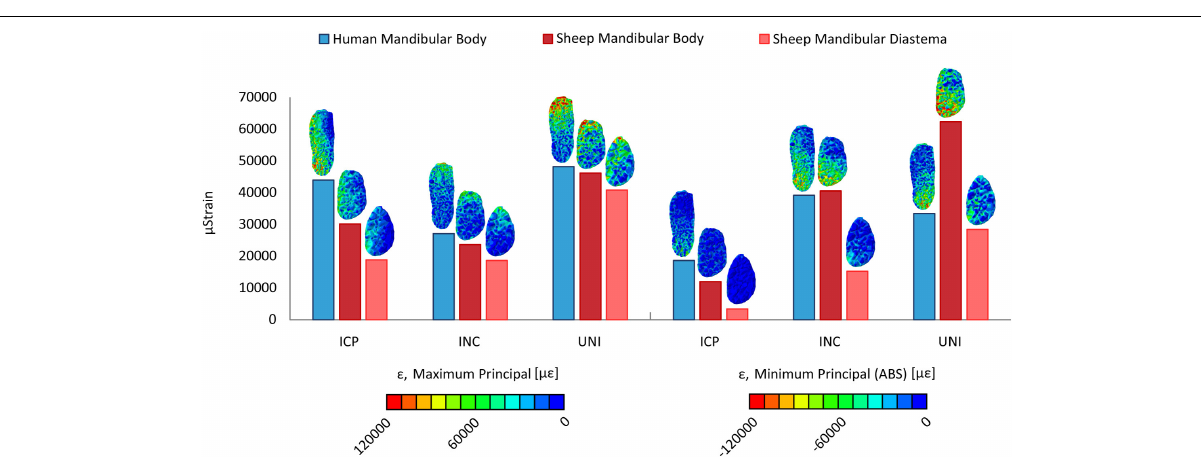
averaging the ten highest stress values, in both the top and